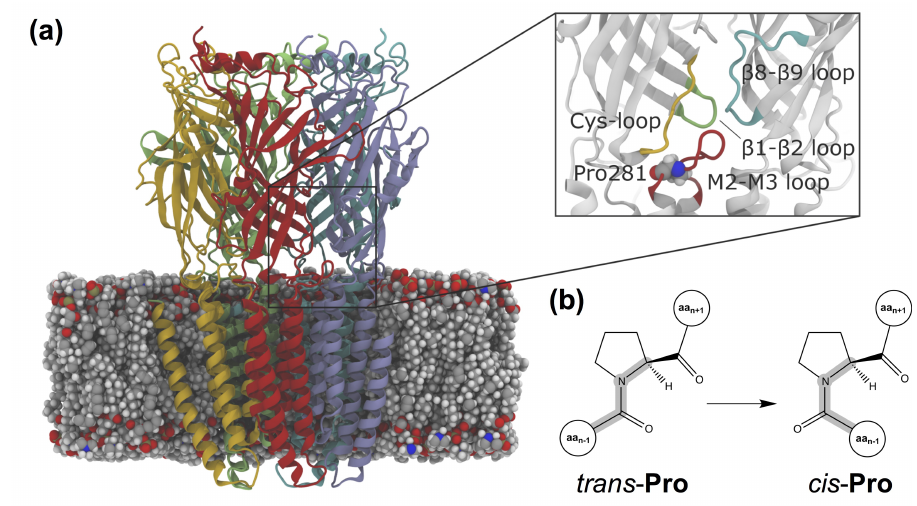
Figure 6. Prolyl isomerization in the serotonin or 5-hydroxytryptamine type 3 (5-HT 3 ) receptor. ( a ) Receptor model embedded in a 1-palmitoyl-2-oleoyl-sn-glycero-3-phosphocholine (POPC) lipid bilayer. The five protein subunits are displayed in red, yellow, green, light blue, and blue, respectively, and the lipid molecules as van der Waals spheres. The inset shows the extracellular domain (ECD)– transmembrane domain (TMD) interface region where the isomerizable Pro281 (in van der Waals spheres) is located, surrounded by the Cys loop (in yellow), the β 1– β 2 loop (green), the β 8– β 9 loop (blue), and the M2–M3 loop (red). Adapted with permission from Crnjar, A.; Comitani, F.; Hester, W.; Molteni, C. Trans–cis proline switches in a pentameric ligand-gated ion channel: how they are affected by and how they affect the biomolecular environment. J. Phys. Chem. Lett. 2019 , 10(3) , 694–700. Copyright 2019 American Chemical Society. ( b ) Schematic representation of the trans-cis isomerization of